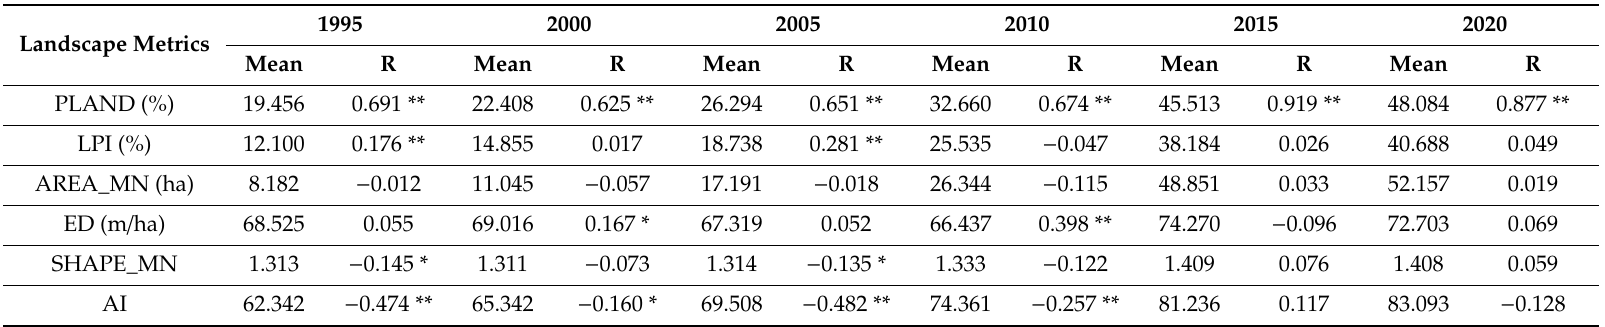
Table 7. Average values and correlations between spatial metrics and mean LST of built-up area patches. Landscape Metrics